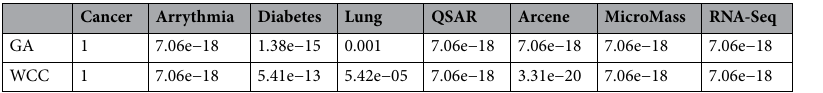
Table 5. A comparison of the obtained results based on the p-value